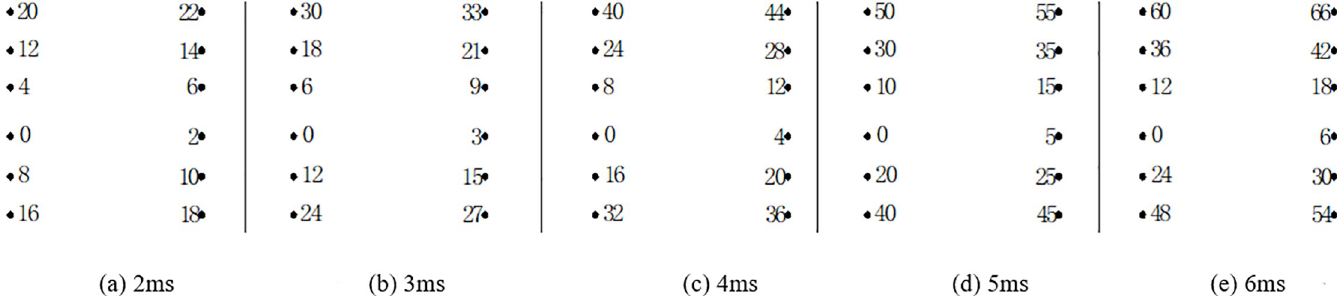
Fig 13. Different delay times for cut